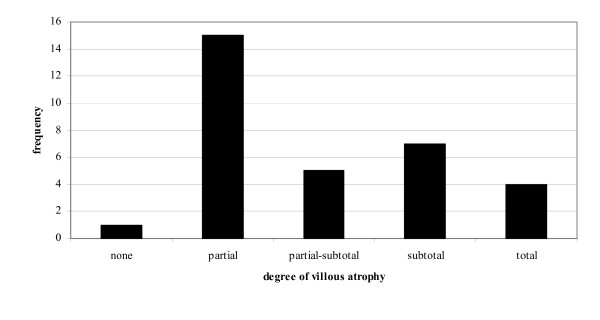
Findings at biopsy.